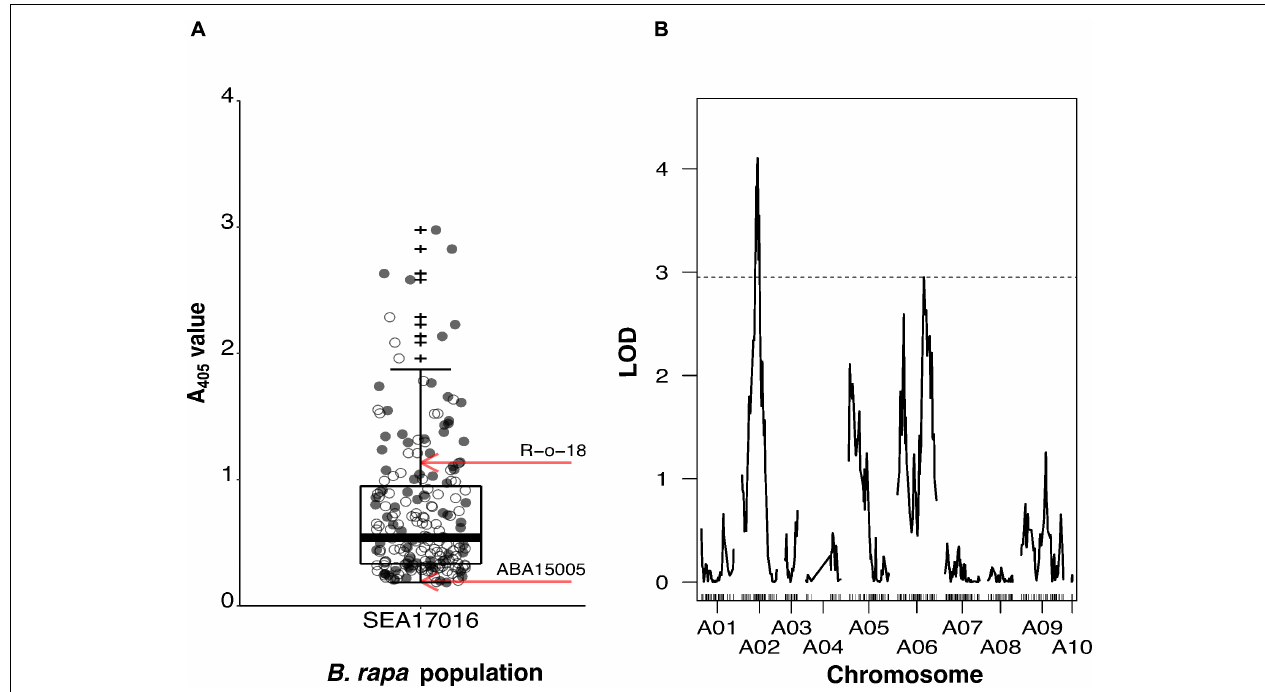
FIGURE 1 | Mapping of turnip yellows virus (TuYV) resistance from Brassica rapa line ABA15005 using the segregating BC 2 population SEA17016. SEA17016 was produced from the cross R-o-18 × BC 1 , where the BC 1 plant was resistant to TuYV. (A) Enzyme-Linked Immunosorbent Assay A 405 values for BC 2 population SEA17016 ( n = 203) and mean values for S 1 populations of the TuYV-resistant parental line ABA15005 ( n = 5) and TuYV-susceptible parental line R-o-18 ( n = 12) indicated by red arrows. Individuals subsequently genotyped for quantitative trait locus (QTL) analysis are indicated as grey points. (B) The LOD plot of QTL analysis of BC 2 population SEA17016, using normalised log 10 (A 405 ) values and Haley–Knott one-dimensional interval mapping. Genome-wide significance LOD threshold ( α ≤ 0.05) of 1,000 permutations is indicated by a dashed horizontal line. Outliers are indicated by